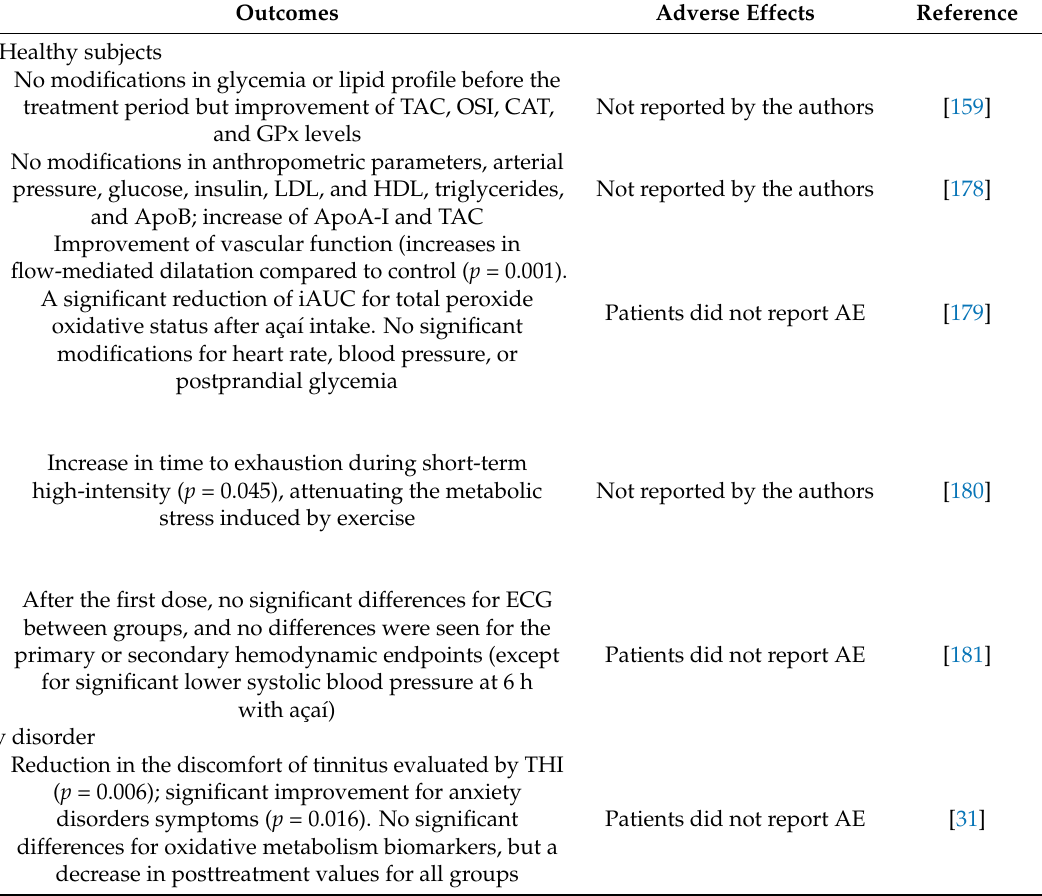
Table 3. Clinical trials showing the effects of aça í on human